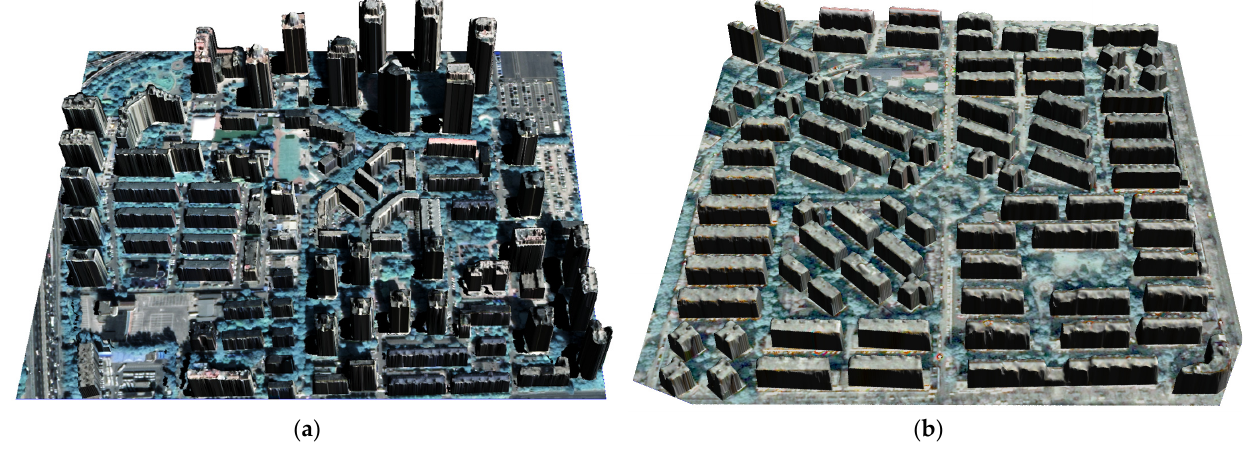
Figure 14. 3D single building model in ( a ) Beijing, and ( b ) Shanghai region.